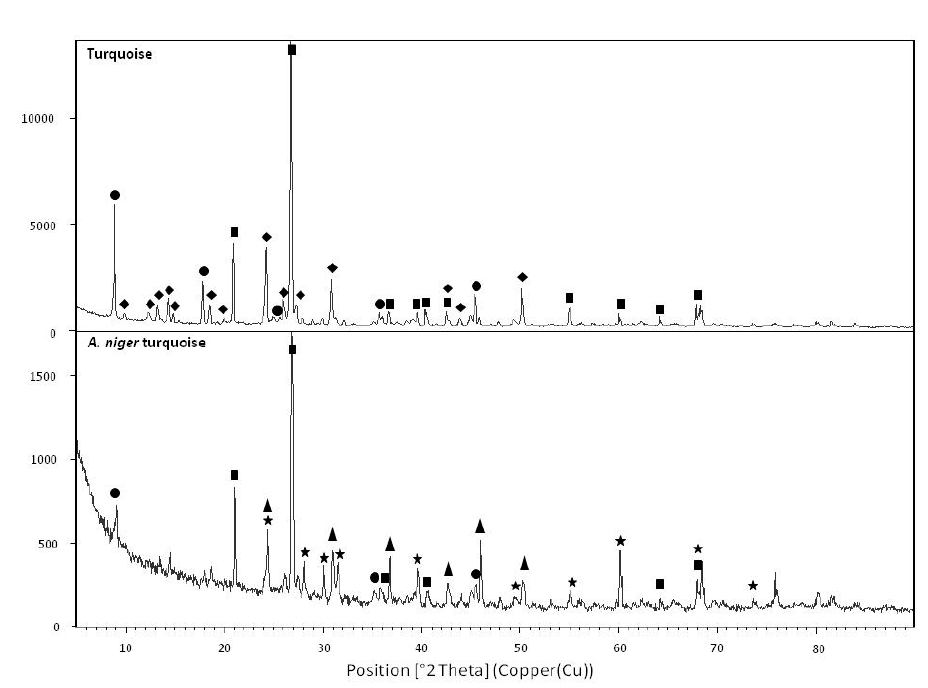
Figure 4. X-ray diffraction (XRD) pattern of the turquoise ( a ) before and ( b ) after 14 days of bioleaching using A. niger ( ● potassium aluminum silicate hydroxide, ■ silicon oxide, ♦ copper aluminum phosphate hydroxide hydrate, copper phosphate, ▲ copper oxalate).